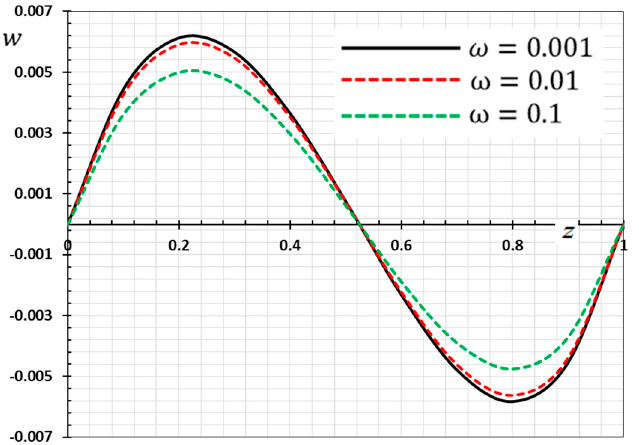
Figure 5. Variation of temperature 𝜃 versus 𝑧 for different delay time 𝜔 .